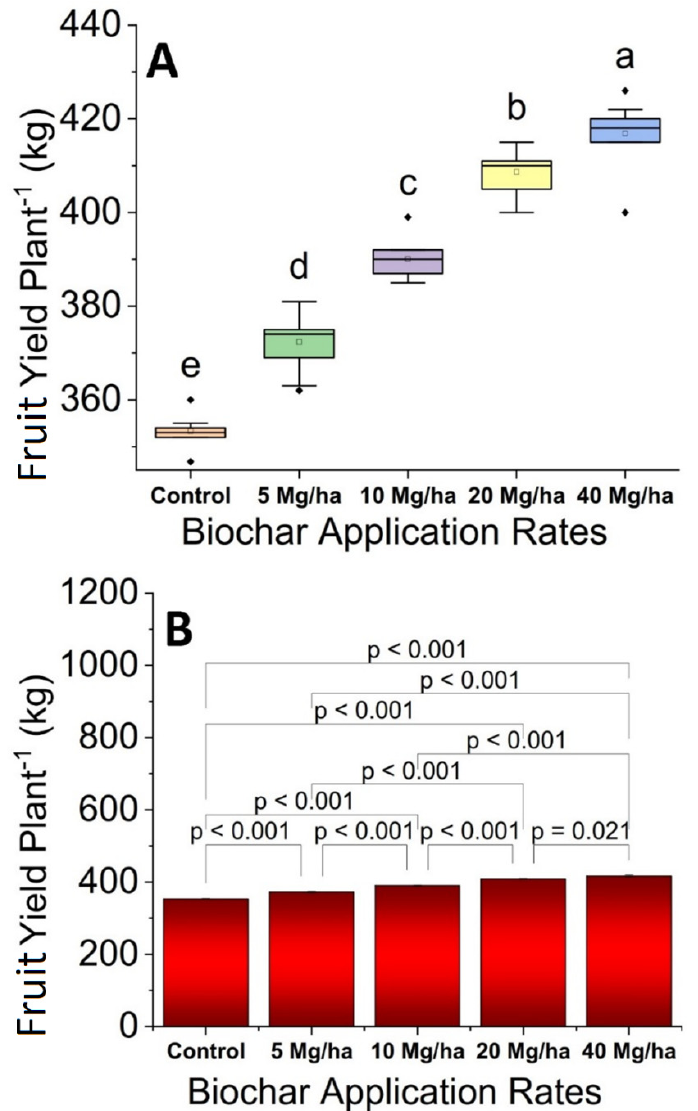
Figure 4. Effect of different biochar application rates on mango fruit yield per plant. Bars are mean of 9 replicates. Different letters show a significant difference at p ≤ 0.05 ( A ). Probability value hierarchy for fruit yield per plant is provided in ( B ).